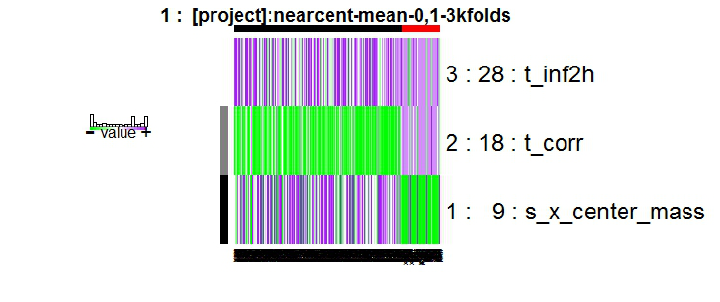
Figure 4. Model obtained from Galgo algorithm with Nearest Centroid (NC)